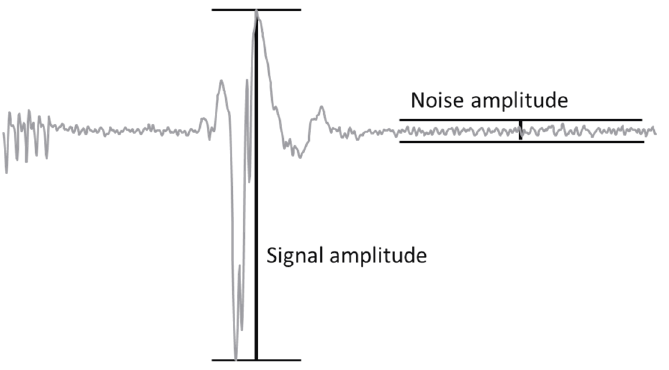
Figure 2. Schematic presentation of an mTc-MEP amplitude and a noise amplitude.